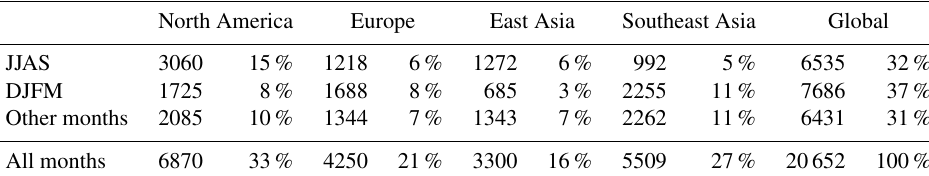
Table 7. Numbers and percentages of individual EnRs for different months and regions. EnRs are associated with a specific region, when the assigned trajectory passes through the box of the region. For the assignment it does not matter whether only one waypoint or the entire trajectory lies inside the box. Assignment to multiple regions occurs, when the trajectory crosses more than one box. The boxes of the respective regions are indicated in Fig. 8. North America Europe